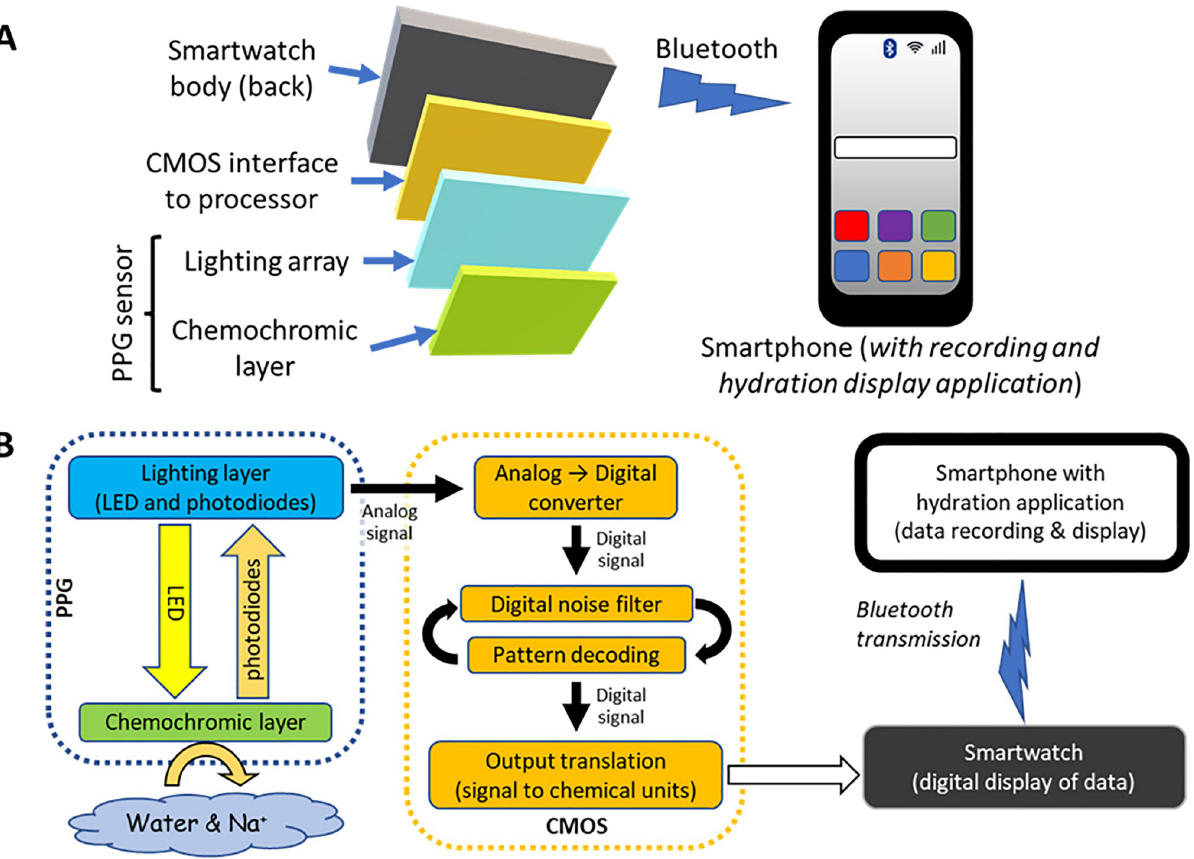
Fig 1. Structural components and data flow of the SpectroPhon-DBM. (A) Component arrangements of PPG sensor and CMOS interface to a smartwatch, Bluetooth-linked to a smartphone with data interpretation application. (B) Data flow diagram of components. Colors represent: green, chemochromic film; blue, lighting layer consisting of LED emitters and photodiode detectors; orange, components of the CMOS interface.